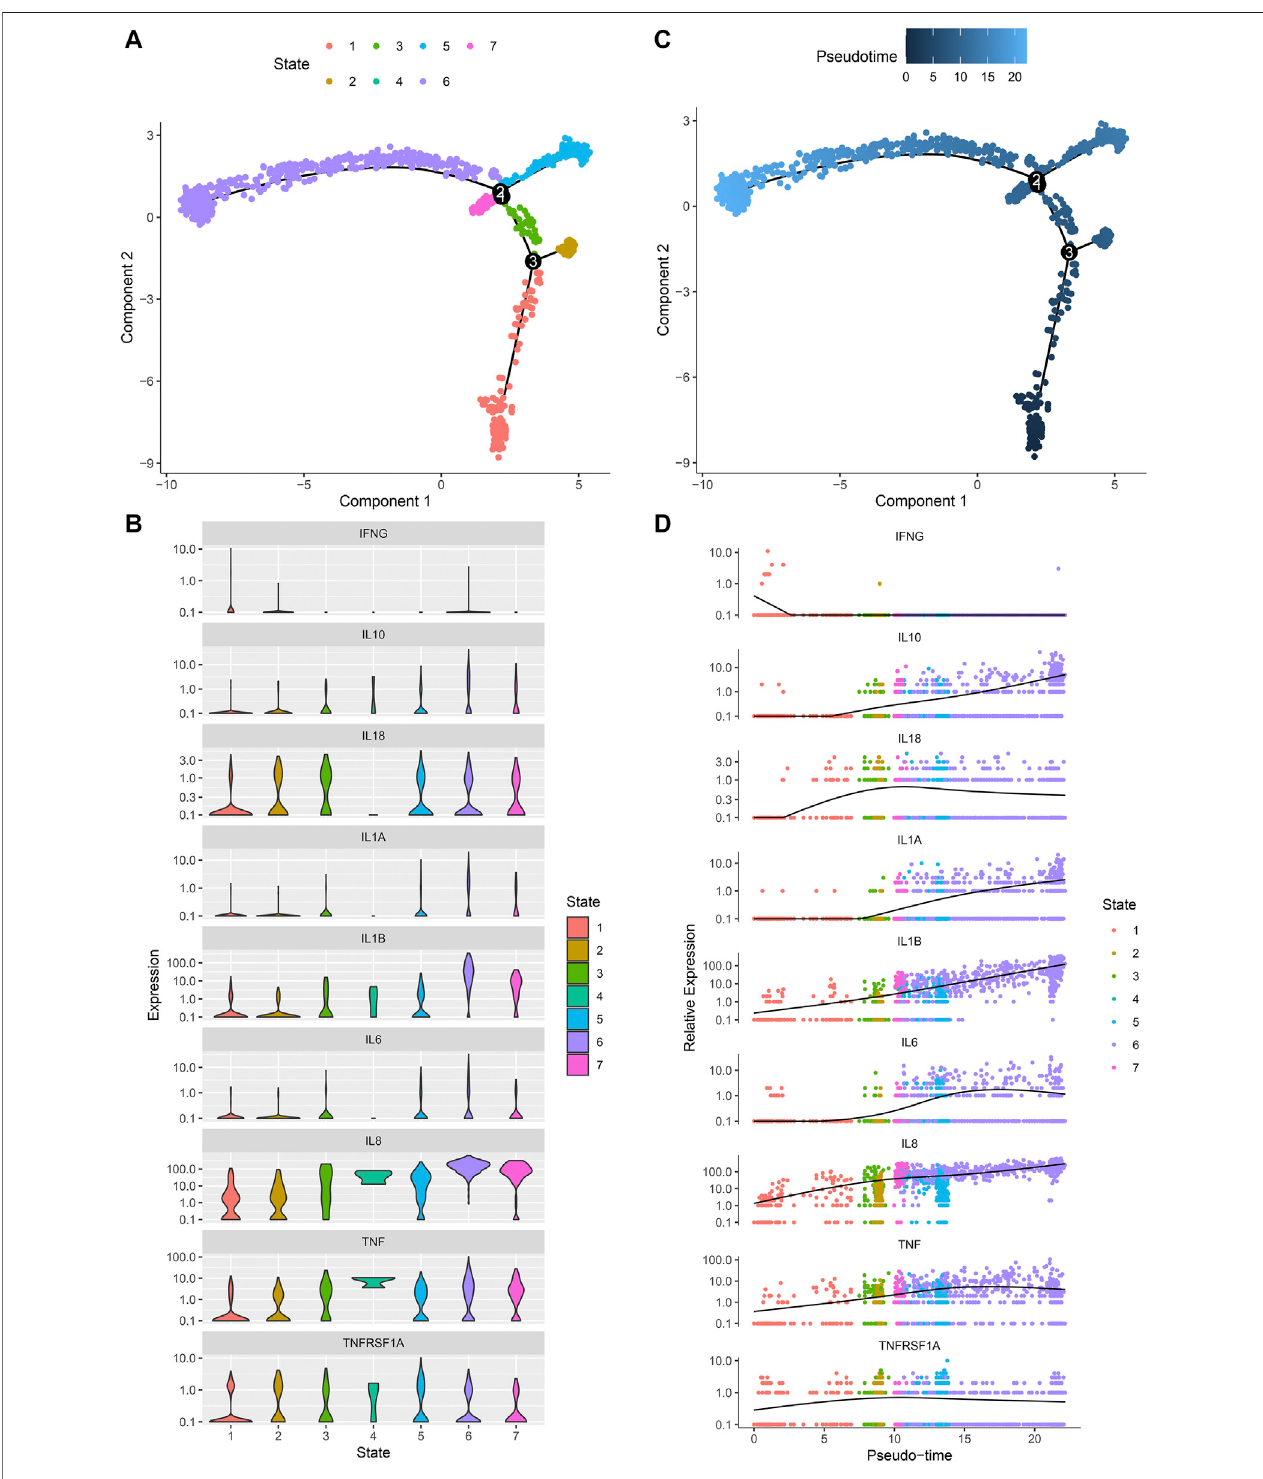
FIGURE 8| Pseudo-time analysis ofosteoarthritic synoviocytes byMonocle2 algorithm. (A) Distributionof osteoarthritic synoviocytes in 7 different states. (B) The mRNA expression of in fl ammatory cytokines and cytokine receptor in each state. (C) Distribution of osteoarthritic synoviocytes according to pseudo-time value. The darker the color, the larger the pseudo-time value. (D) Genes that dynamically change with pseudo-time value.